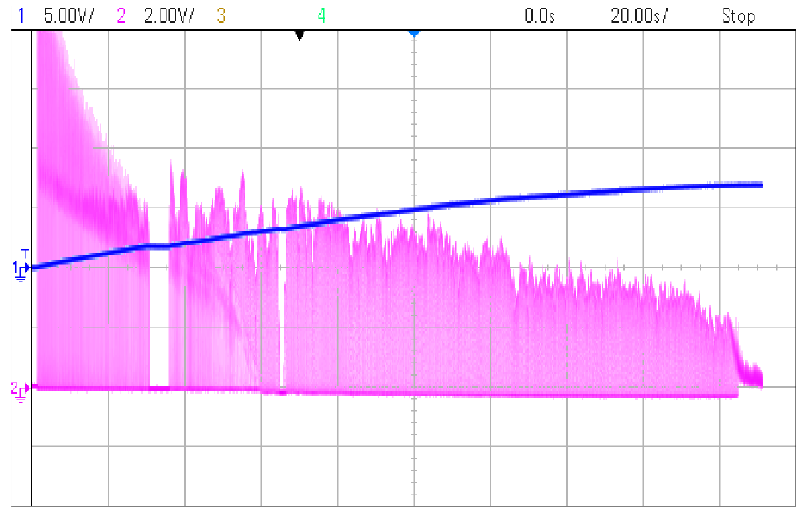
Figure 22. The voltage (blue) and current (purple) waveforms of the supercapacitor.